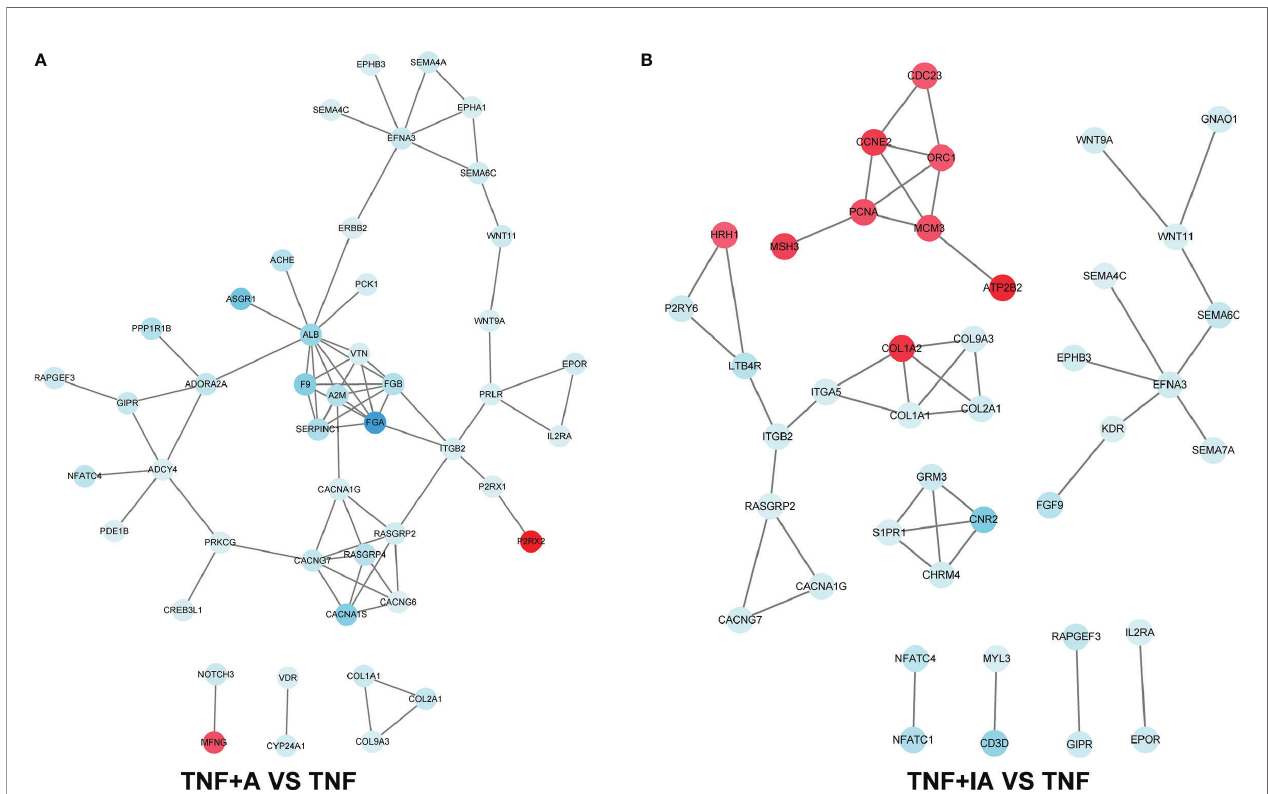
FIGURE 7 | The protein-protein interaction network based on the KEGG annotation. (A) Change of protein abundance in TNF+A group compared to group TNF. (B) Change of protein abundance in TNF+IA group compared to group TNF. TNF, cells challenged with 20 ng/mL Recombinant Susscrofa TNF- a for 48 hours. TNF+A, cells challenged with 20 ng/mL TNF- a for 40.5 h and then co-cultured with 10 8 copies/mL active A. muciniphila for 7.5 h. TNF+IA, cells challenged with 20 ng/mL TNF- a for 40.5 h and then co-cultured with 10 9 copies/mL inactive A. muciniphila for 7.5